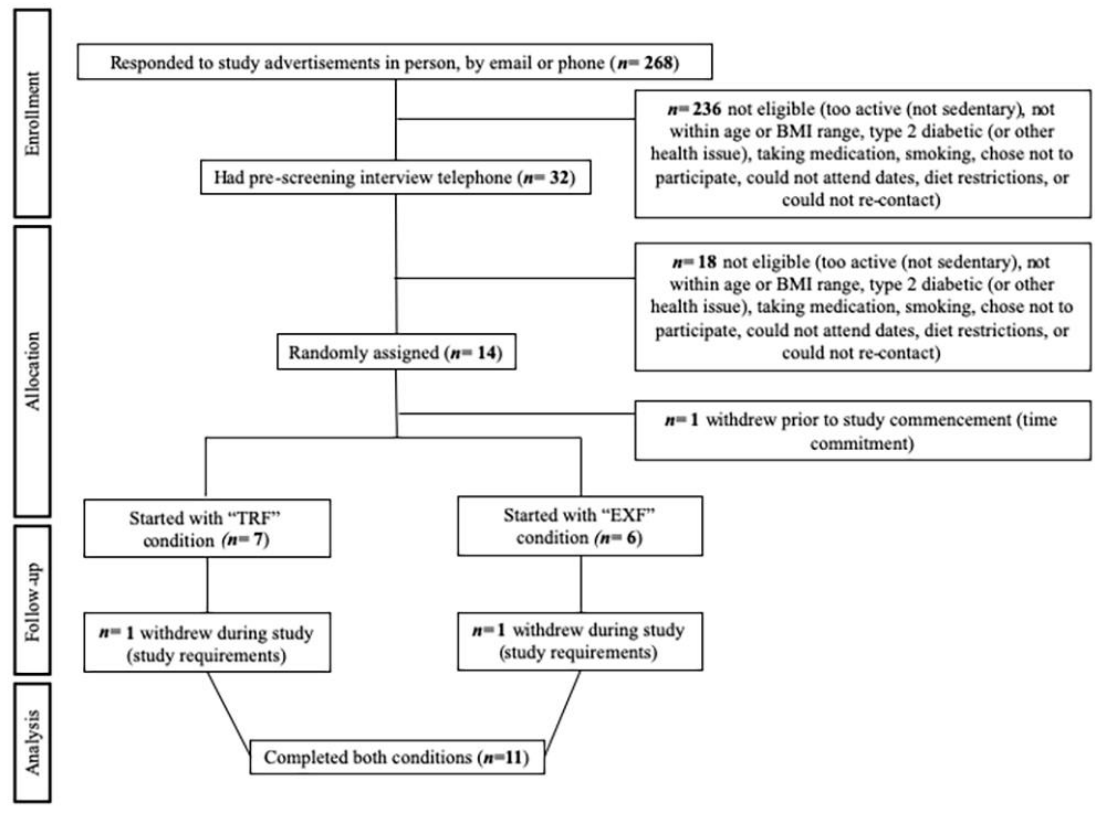
Figure 2. Consolidated Standards of Reporting Trials (CONSORT) flow diagram of participant recruitment.